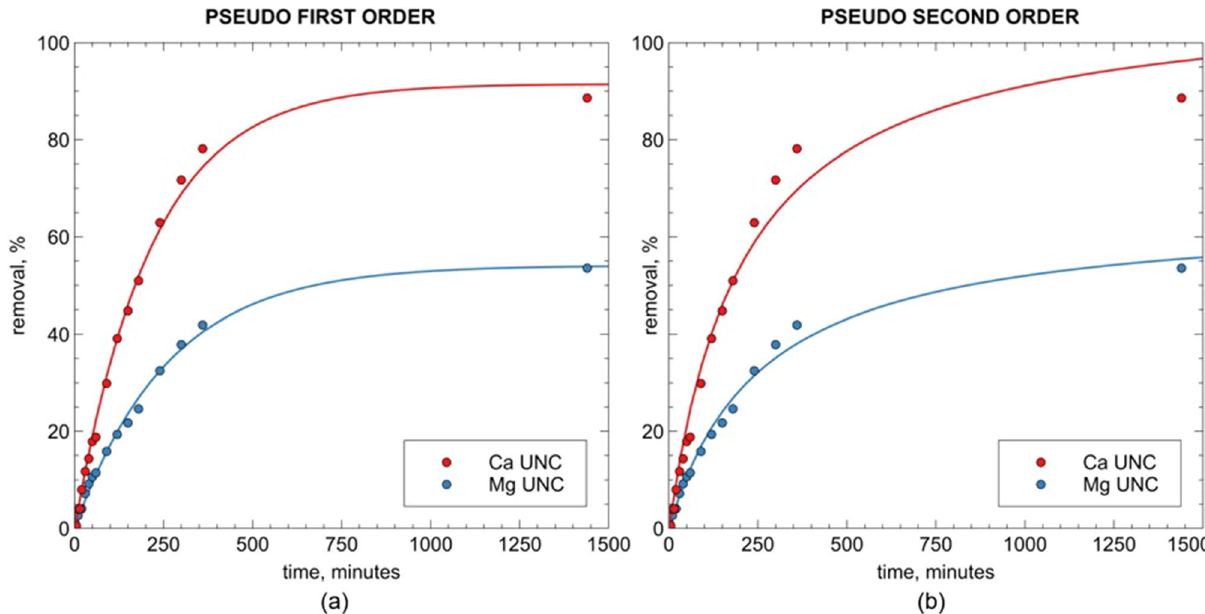
Figure 6. Modeling results for calcium and magnesium kinetic curves for ZEOP sample under uncontrolled pH conditions.